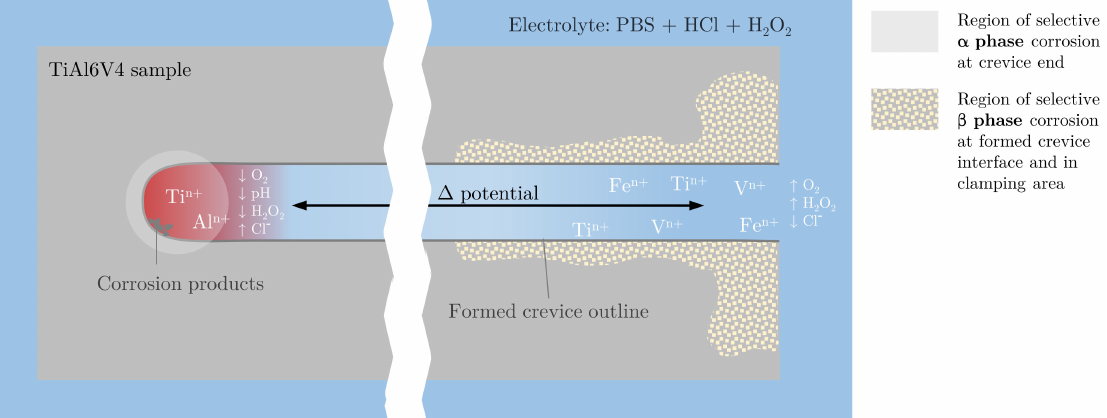
Figure 9. Schematic of the observed corrosion damage locations on TiAl6V4 alloy previously clamped with a PTFE crevice former and immersed for four weeks in PBS with a concentration of 170 mM of HCl and 30 mM of H 2 O 2 (top view on a TiAl6V4 sample with crevice outline after the disassembly of the PTFE crevice